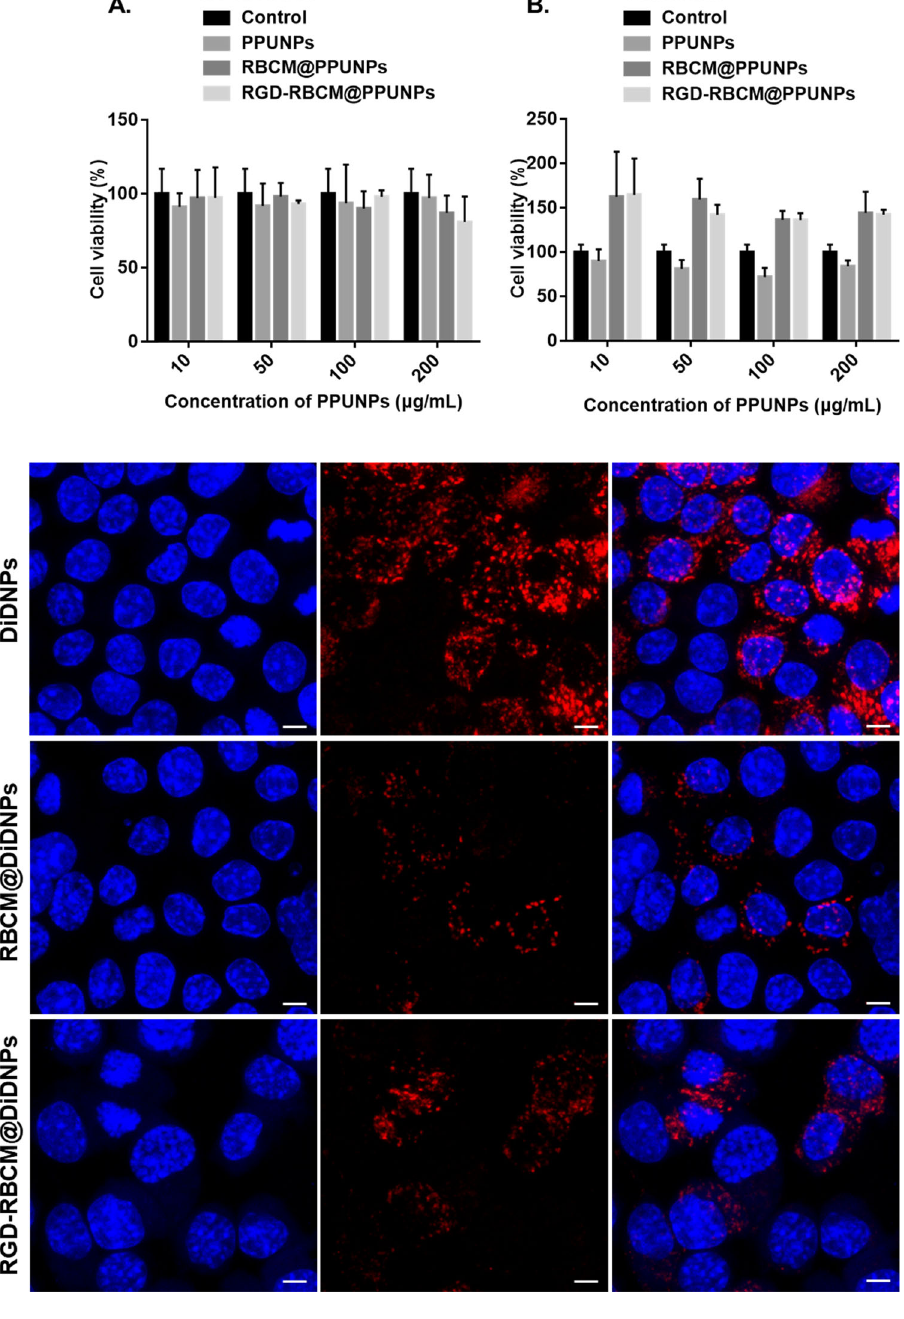
Fig. 7 The cell viability of endothelial cells ( A ) and smooth muscle cells ( B ) after treatment with PPUNPs, RBCM@PPUNPs, or RGD-